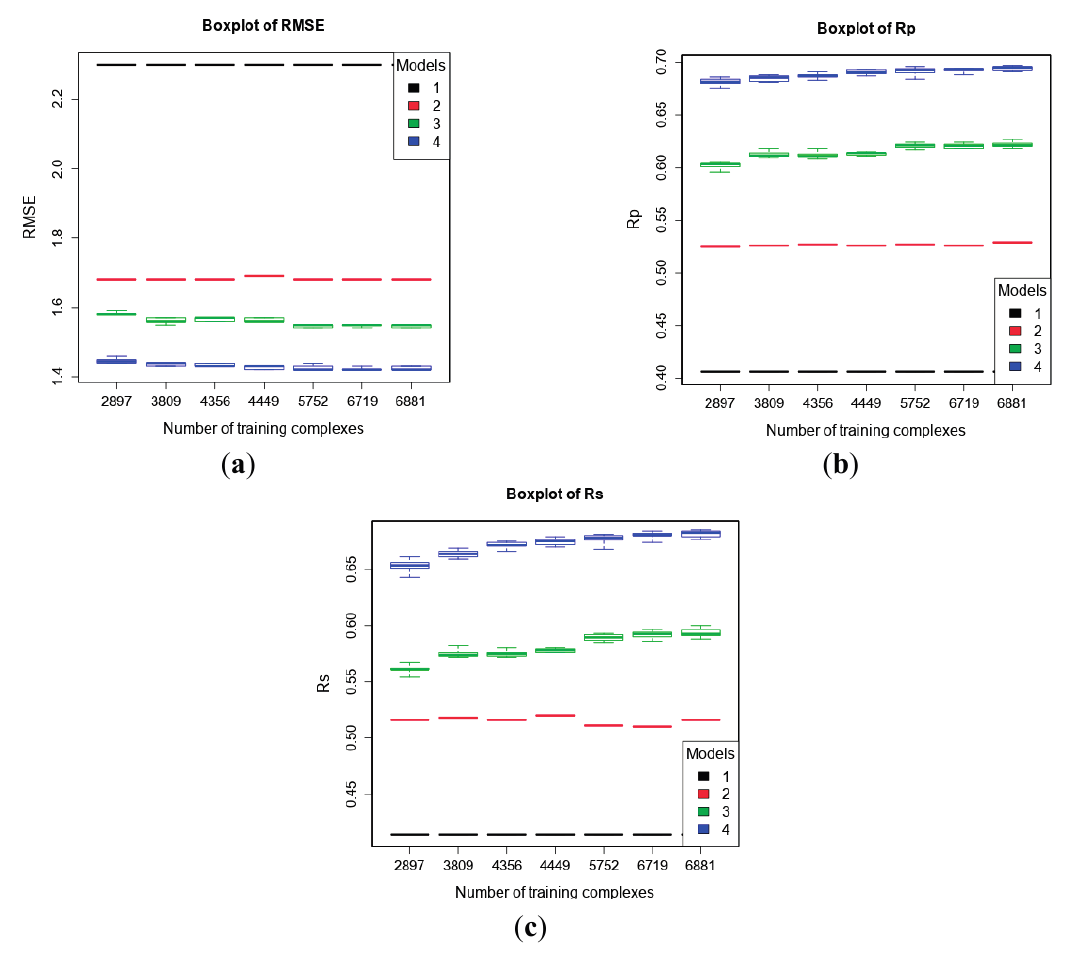
Figure 5. Performance of the four models trained with seven purposely-partitioned subsets of PDBbind v2012 general set on the test set of v2013 refined set minus v2012 refined set ( n = 382) according to RMSE ( a ); R p ( b ); and R s ( c ). Models: 1 (Vina), 2 (MLR::Vina), 3 (RF::Vina) and 4